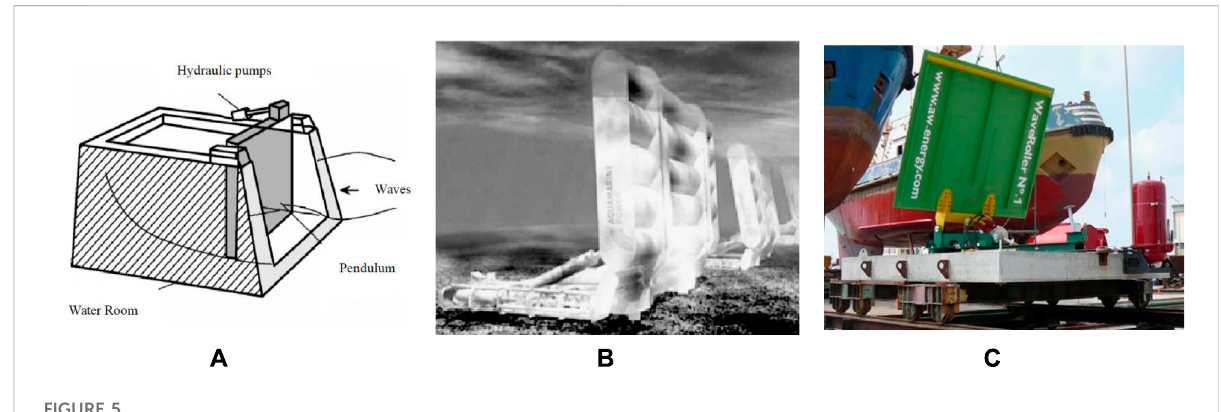
FIGURE 5 Pendulumwaveenergyconversiondevice (A) Theoffshoretype. (B) Theseabedtype(Xiaoetal.,2014b). (C)